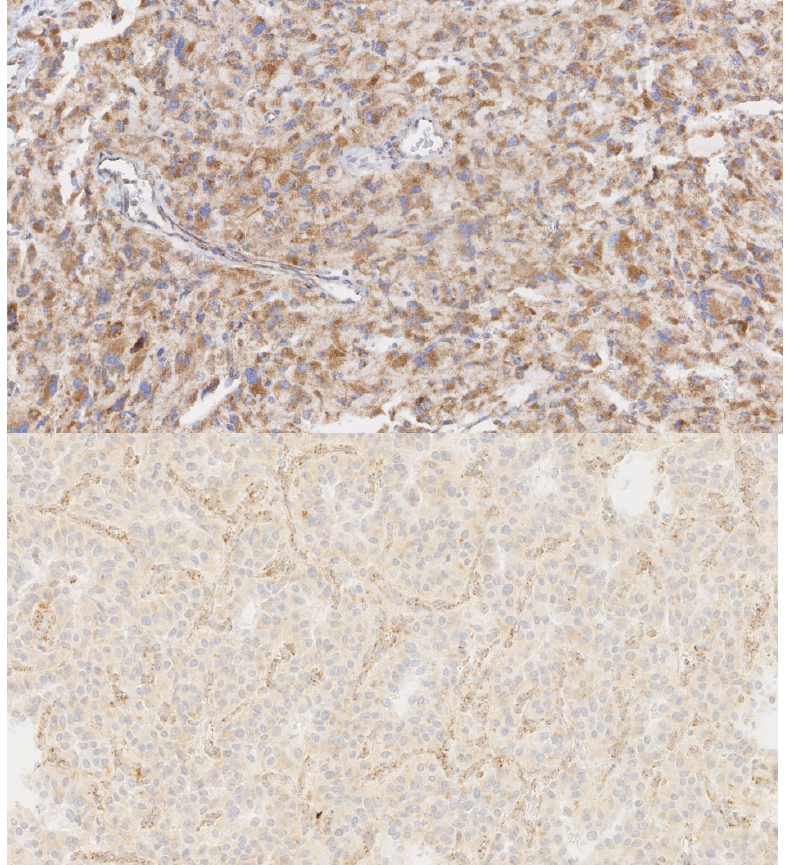
Figure 1. SDHB immunohistochemistry of paraganglioma with normal staining pattern in upper panel, showing strong diffuse granular staining in the cytoplasm of all cells. Lower panel shows absent staining in tumor cells. Note the remaining cytoplasmic granular staining in pre-existent normal endothelial cells and fibroblasts. Magnification: 400×